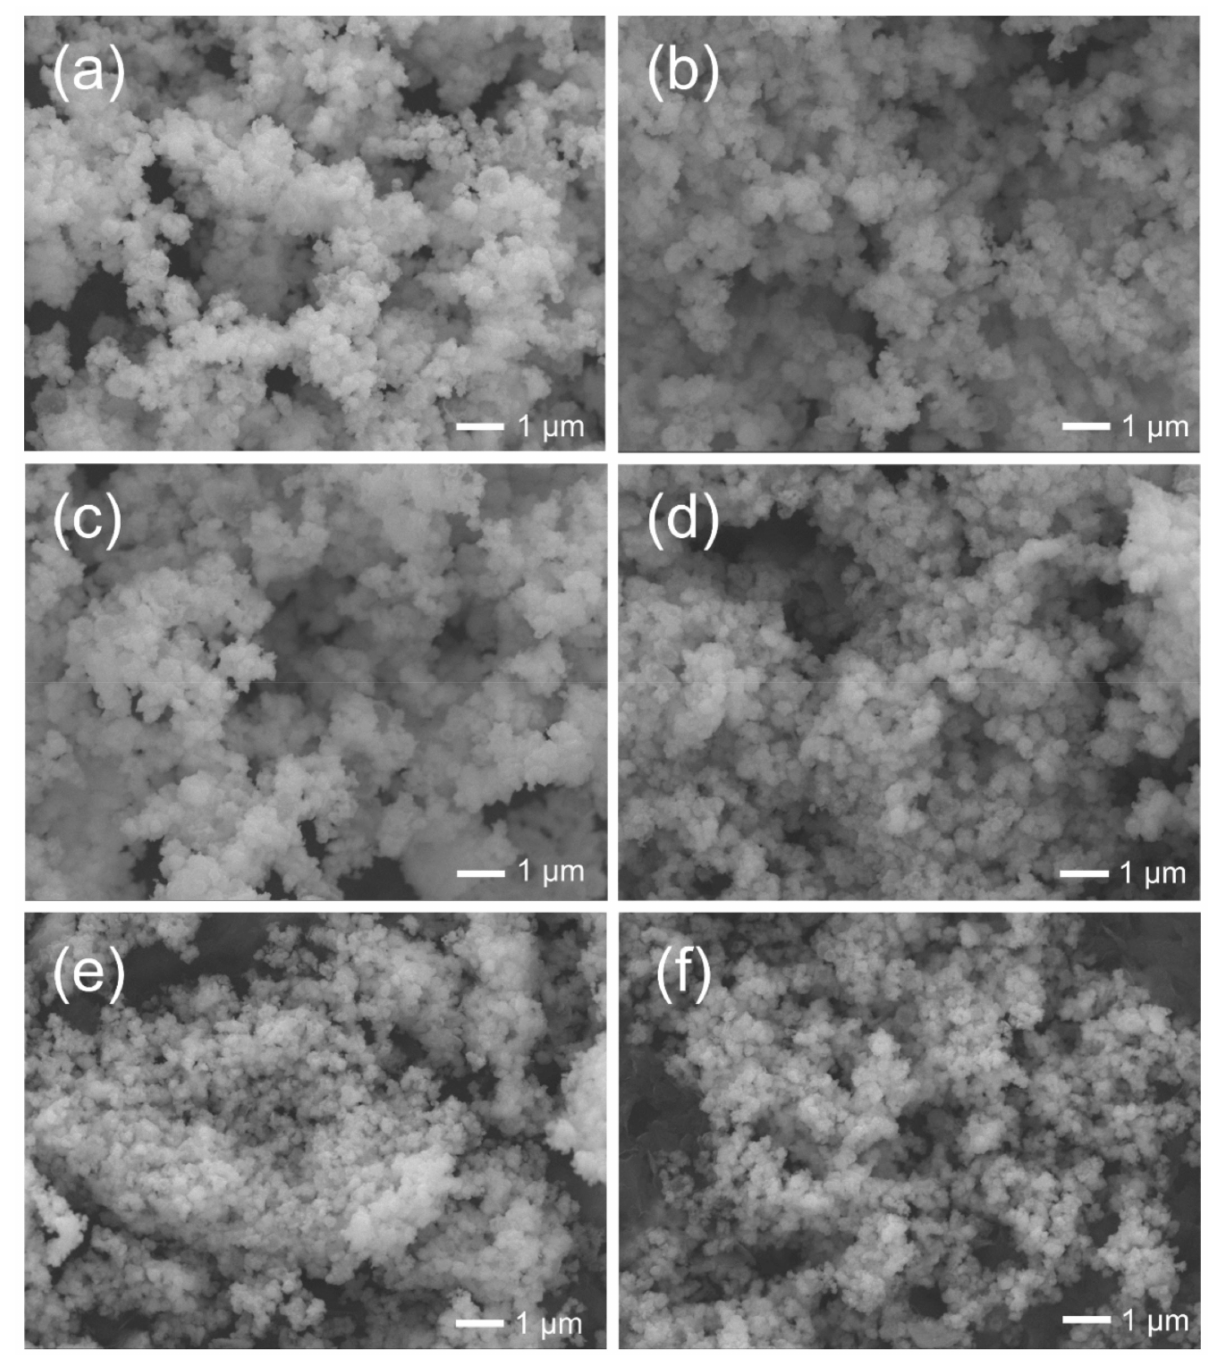
Figure 6. SEM images of ( a ) CeO 2 -NS 2 h before calcination; ( b ) CeO 2 -NS 2 h; ( c ) CeO 2 -NS 4 h before calcination; ( d ) CeO 2 -NS 4 h; ( e ) CeO 2 -NS before calcination, and ( f ) CeO 2